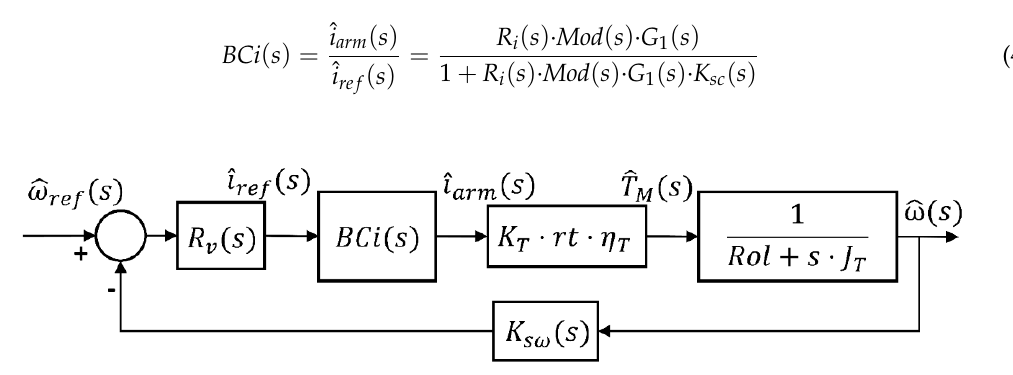
Figure 11. Block diagram with a simplified inner loop.